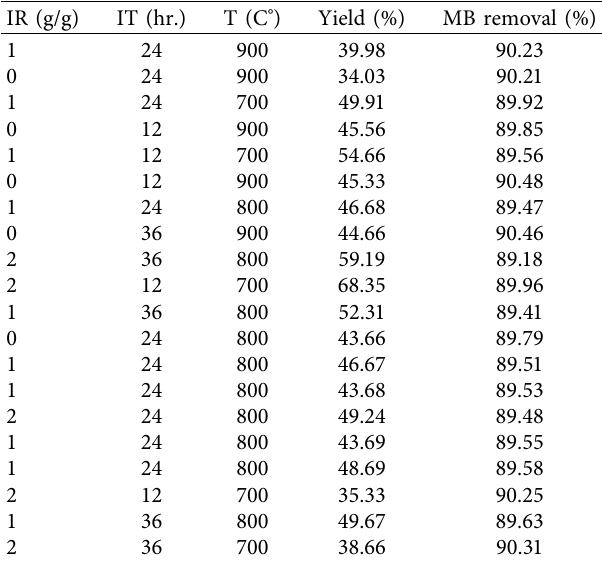
Table 2: Optimization of STAC